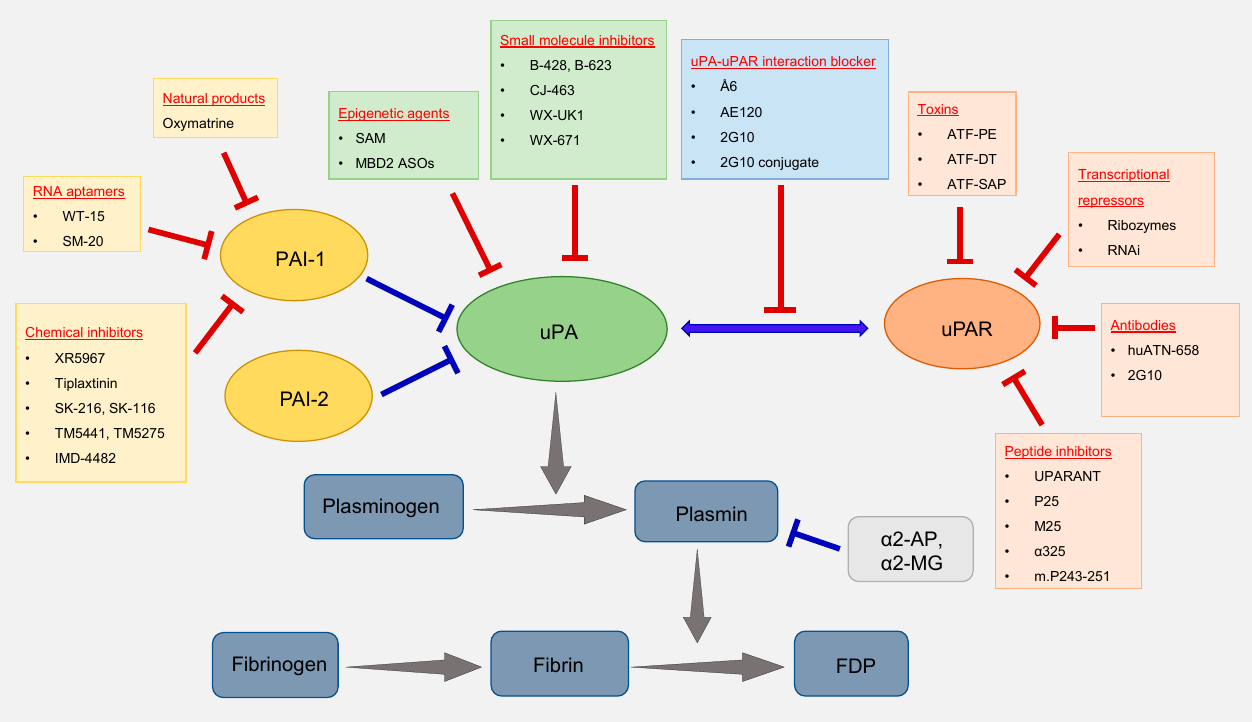
Figure 1. Components of the fibrinolytic system. The drug/inhibitors targeting the key members of the fibrinolytic system (uPA, uPAR, and PAI-1) that are deregulated in cancer are listed inside the colored boxes.